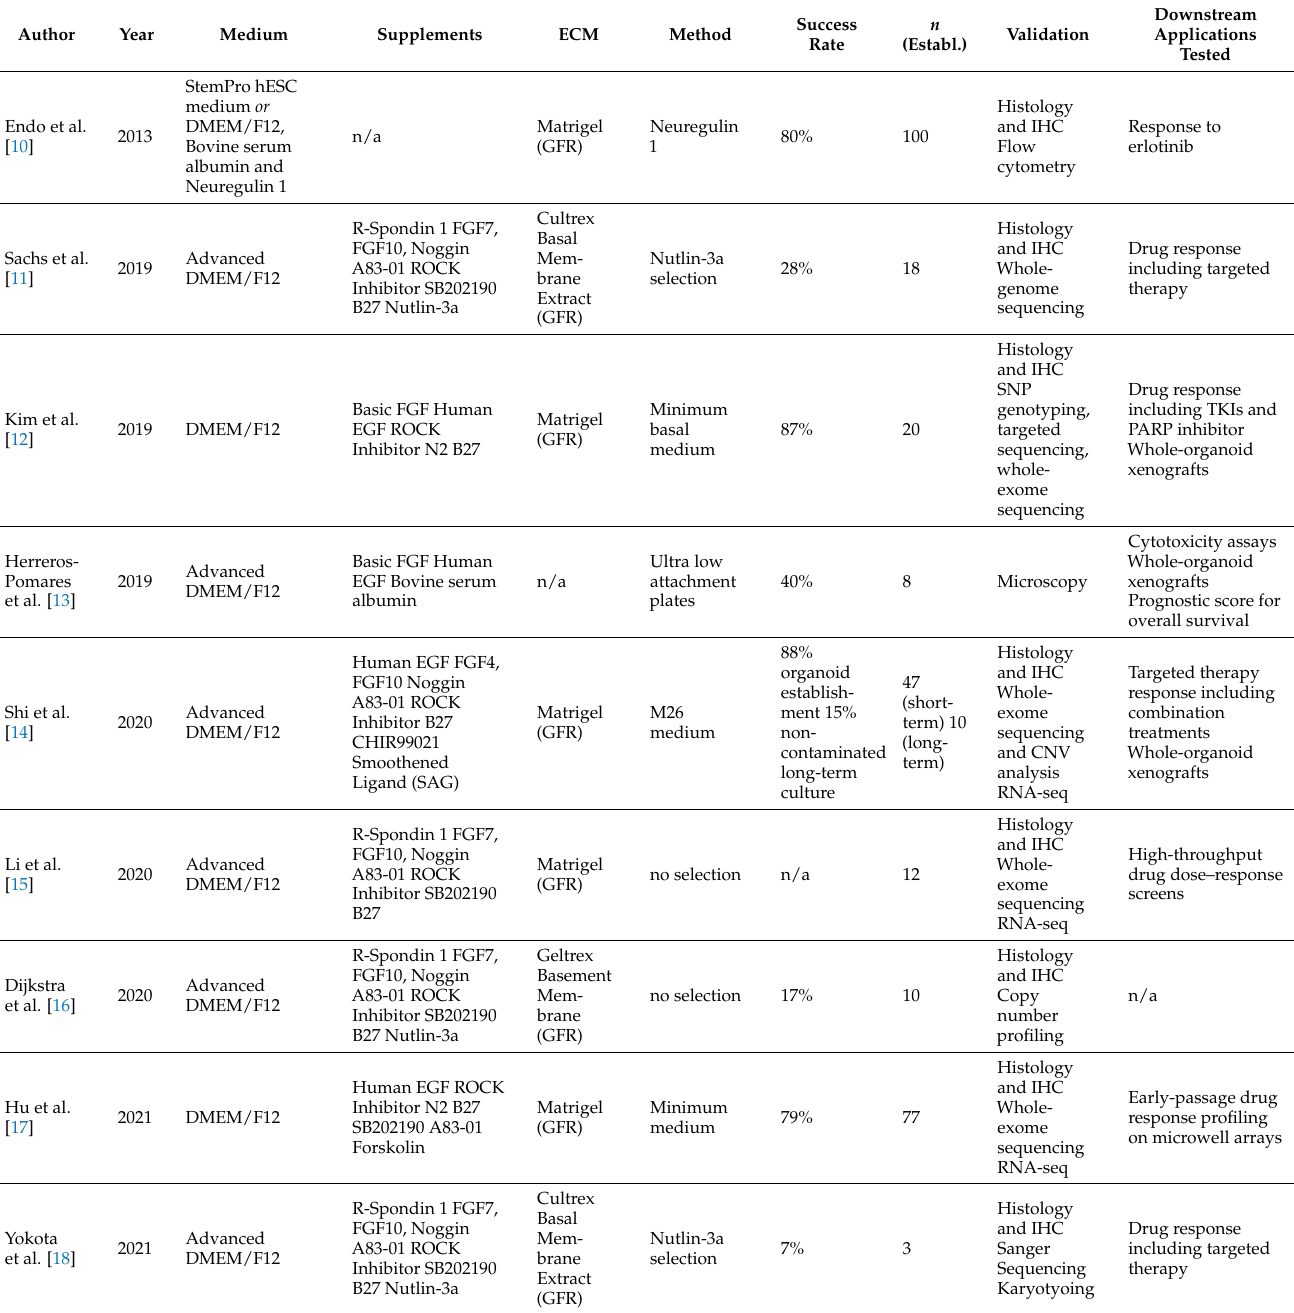
Table 1. Primary non-small cell lung cancer organoid